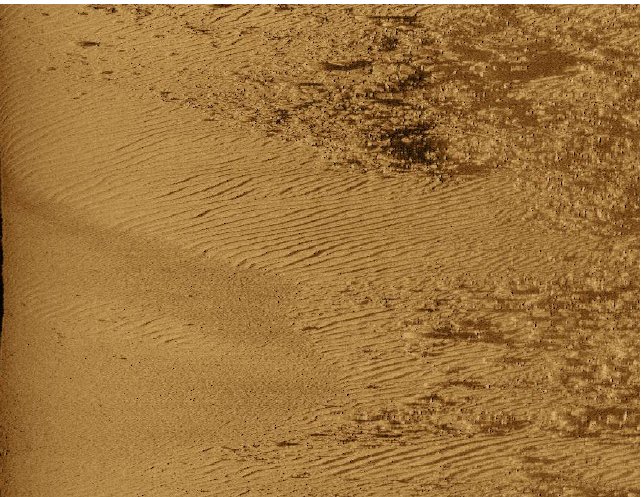
Figure 11. High-resolution side-scan image (New EdgeTech, HRSSS, 600/1,600 kHz from National Oceanic and Atmospheric Administration (NOAA) R/V Storm; 0.6 cm resolution) of stamp sands encroaching into Buffalo Reef cobble fields (site 2; Figure 5). Drifting stamp sands are on the left side of the image, whereas boulder fields are on the right side. Notice the ripples along the leading edge of the stamp sands and how the fine sand particles fill in crevices in the cobble/boulder